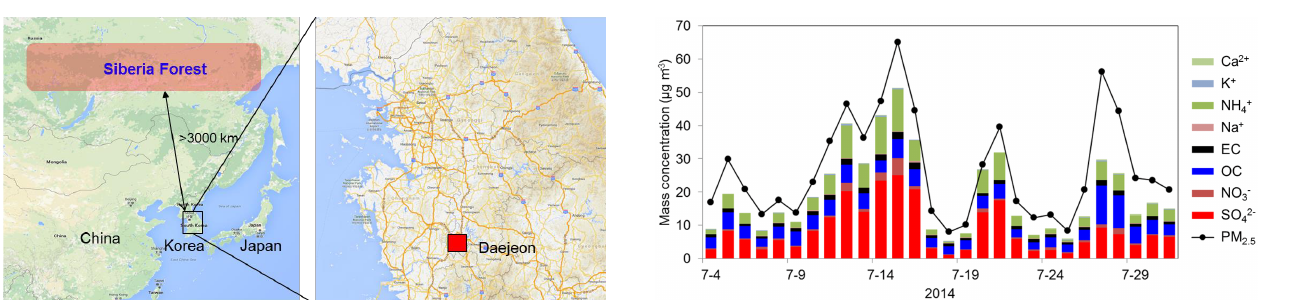
Figure 1. Map of the measurement site (36.19 ◦ N, 127.24 ◦ E) in Daejeon, Korea (base map from Google Maps). The Siberian forest is located ∼ 3000km north of the Korean Peninsula.